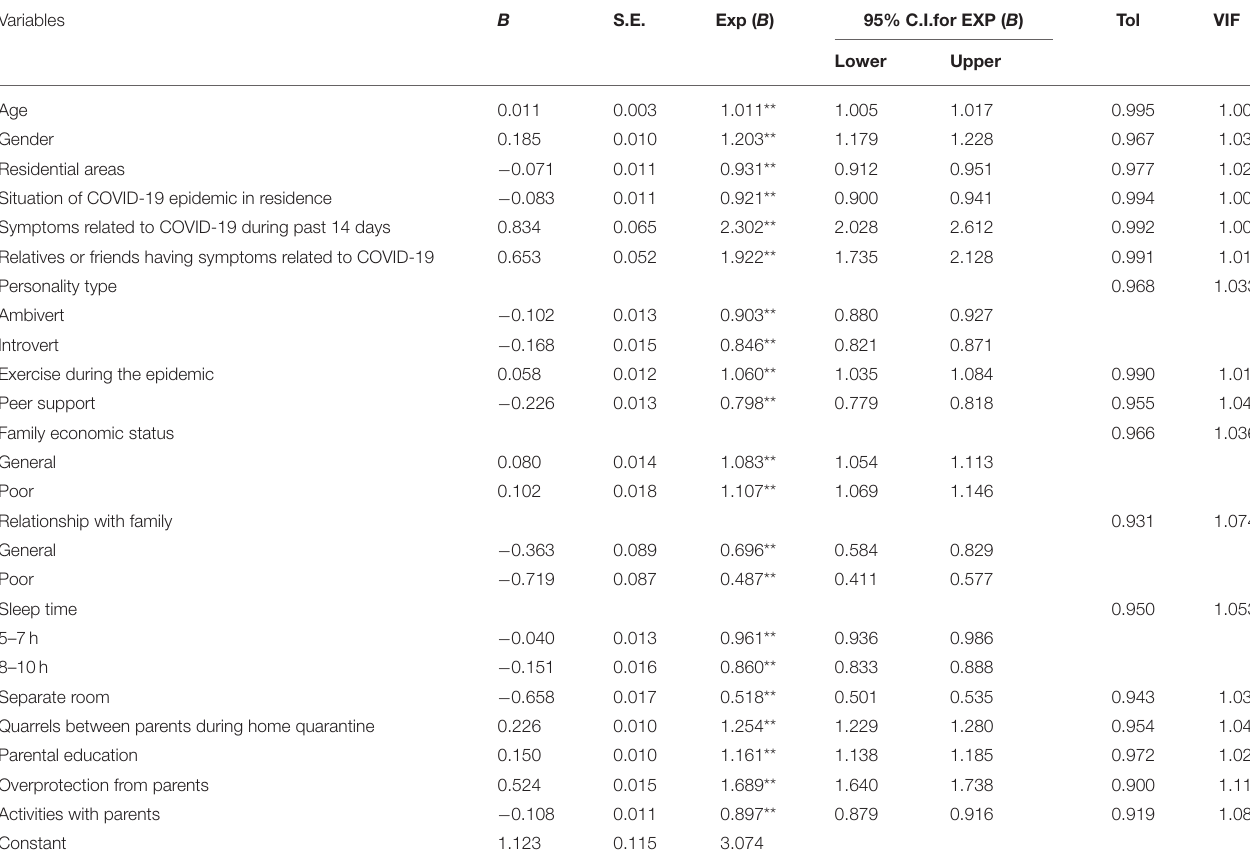
TABLE 3 | Binary logistic regression: the risk and protect factors of PTSS.